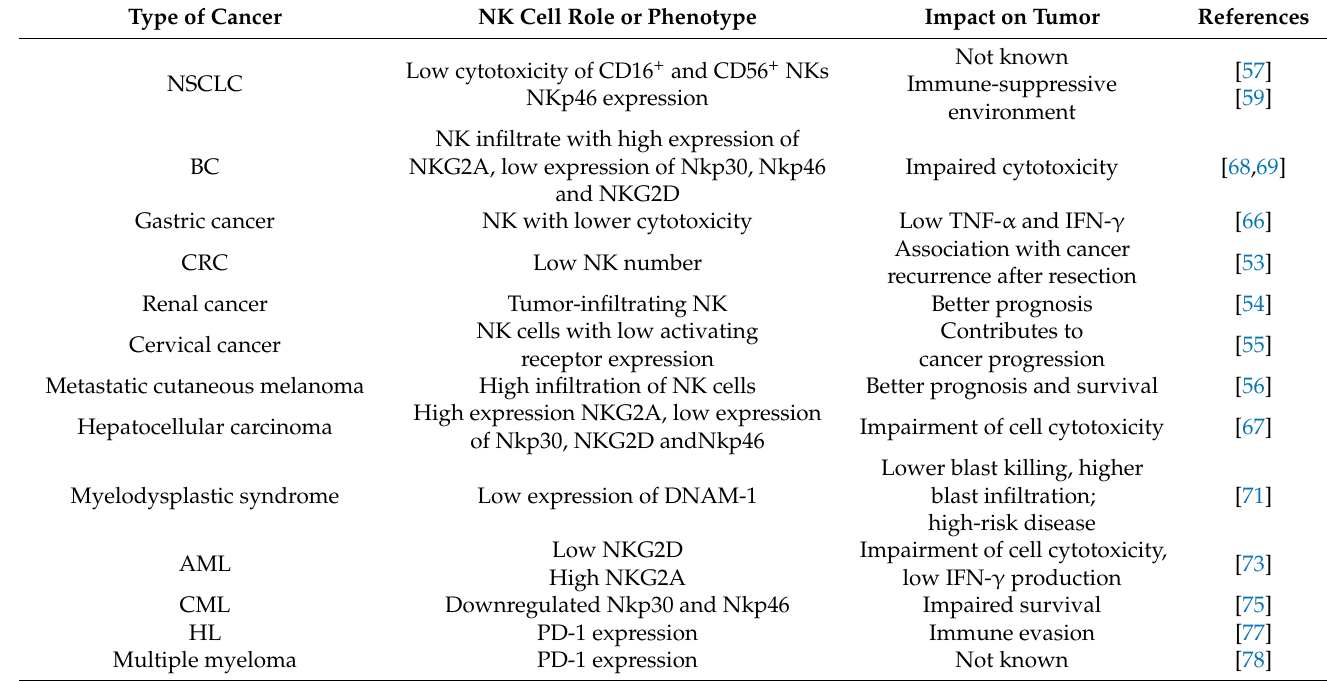
Table 1. NK roles and phenotypes in different types of cancer: NSCLC (non-small-cell lung cancer), BC (breast cancer),